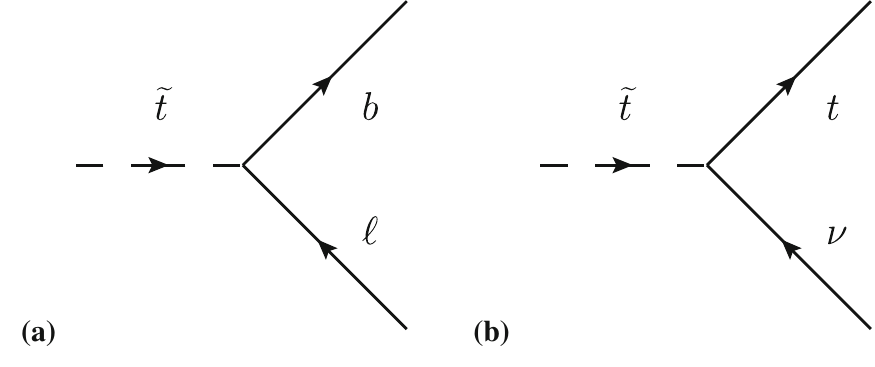
Fig. 2 Dominant decay channels in the μν SSM for a stop LSP. a bottom and leptons; b top and